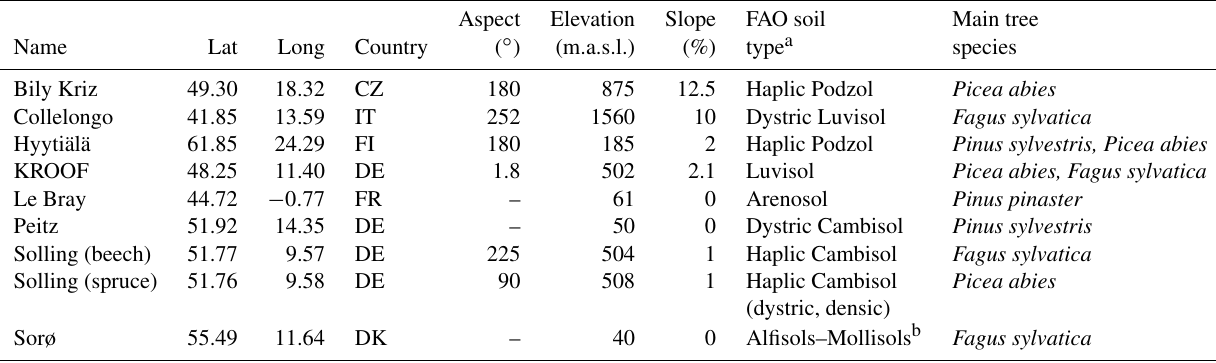
Table 2. Overview of the main site characteristics provided for each forest site in the PROFOUND DB. Aspect Elevation Slope FAO soil Main tree Name Lat Long